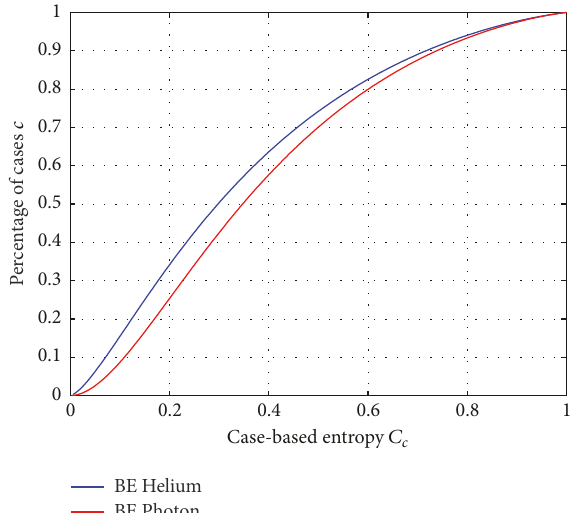
Figure 3: 𝐶 𝑐 versus 𝑐 for Helium-4 and for photons. Note: the results of calculations carried out at 𝑇 = 50 K, 500 K, and 5000 K are